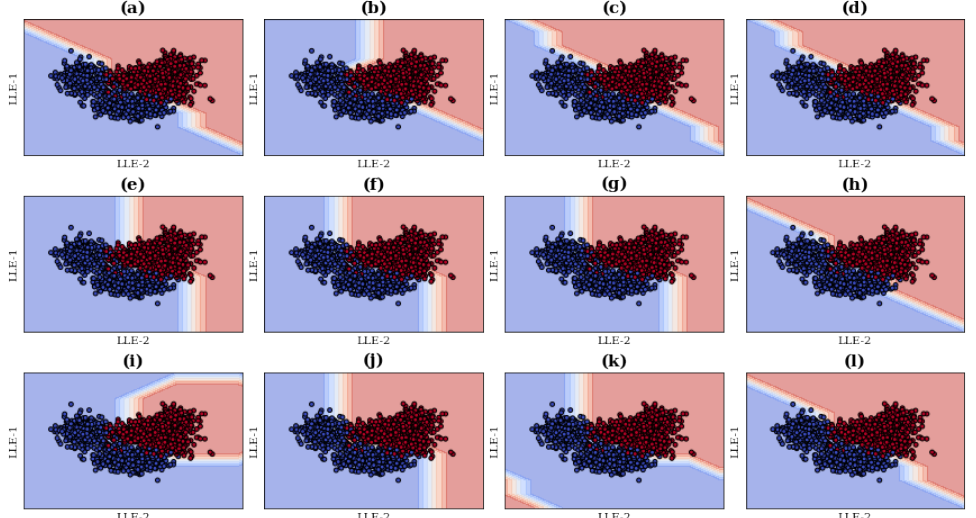
Figure 14. Fault isolation results by ( a ) LR, ( b ) KNN, ( c ) SVM-Lin, ( d ) SVM–RBF ( C = 10), ( e ) GBC (number of estimators = 1000), ( f ) DT, ( g ) RF, ( h ) MLP, ( i ) GBC, ( j ) ABC, ( k ) QDA, and ( l ) GPC. The data points in blue and red circles represent the LLE samples for healthy and faulty states of the gear pump. As shown by the grids, each of the algorithms are quite effective for creating a distinctive hyper-plane between both operating conditions; hence, they are suitable for early wear